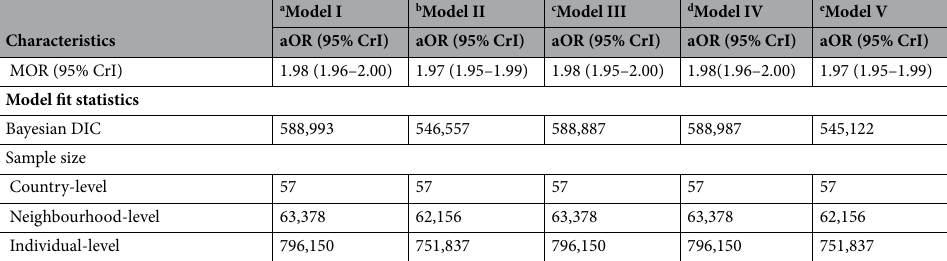
Table 3. Individual, neighbourhood and country factors associated with the diarrhoea identified by multivariable multilevel logistic regression models, DHS data, 2010–2018. The OR in bold suggest significance at 5% OR odds ratio, CrI credible interval, MOR median odds ratio, VPC variance partition coefficient, DIC Deviance Information Criteria. a Model I—empty null model, baseline model without any explanatory variables (unconditional model). b Model II—adjusted for only individual-level factors. c Model III—adjusted for only neighbourhood-level factors. d Model IV—adjusted for only country-level factors. e Model V—adjusted for individual-, neighbourhood-, and country-level factors (full